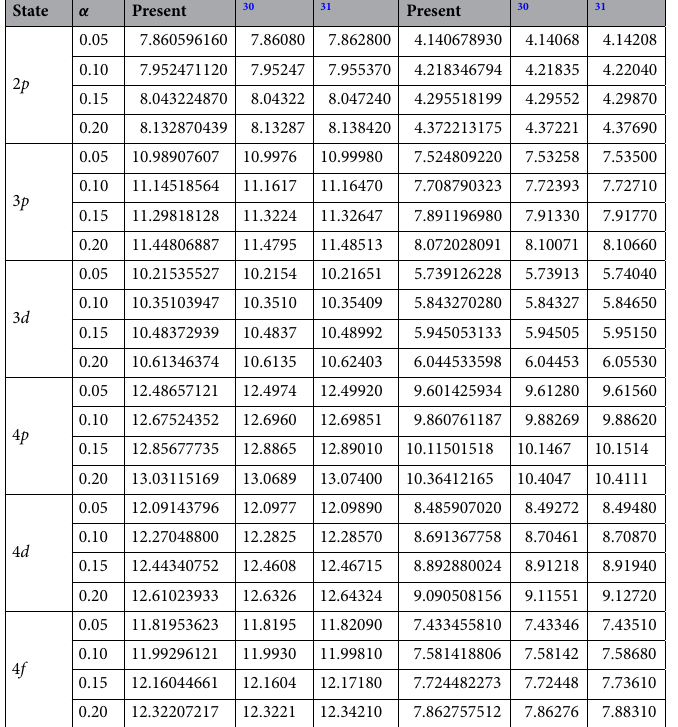
Table 2. Comparison of energy eigenvalues as a function of the parameter a for 2 p , 3 p , 3 d , 4 p , 4 d and 4 f states (cid:31) 2. 1, and (cid:31) 0 with µ = = =